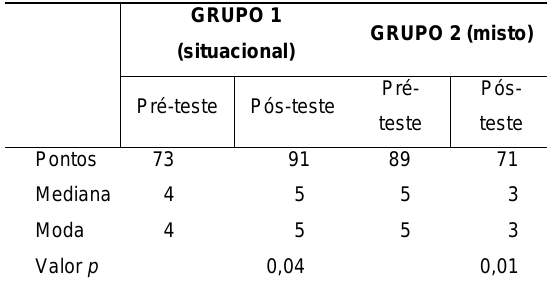
Tabela 2. Resultado do pré-teste e do pós-teste para conhecimento tático processual KORA: OO convergente